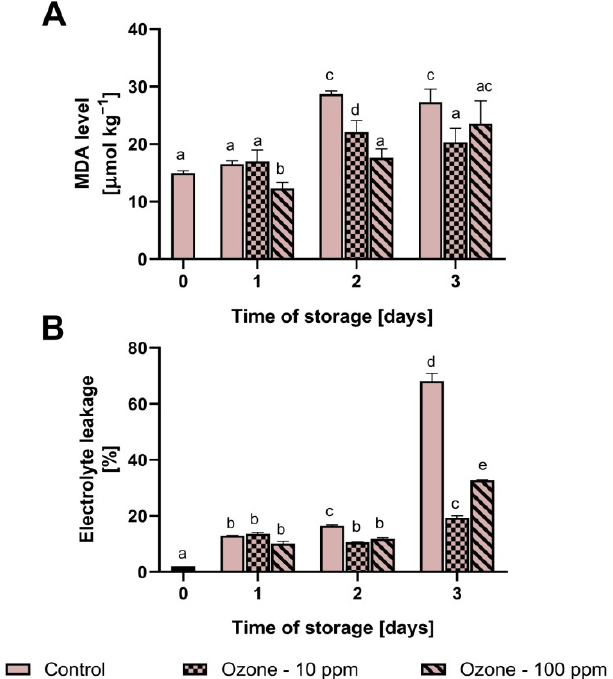
Figure 5. Effect of ozonation process on the level of malondialdehyde ( A ) and electrolyte leakage ( B ) in fruit during storage. Mean values with standard deviations (error bars), with the same lower case are not statistically significant according to the t-Tukey test ( α = 0.05).